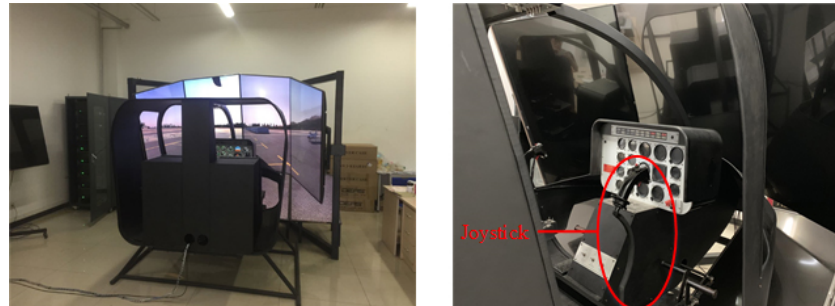
Figure 1. The helicopter simulator in Yanshan University.